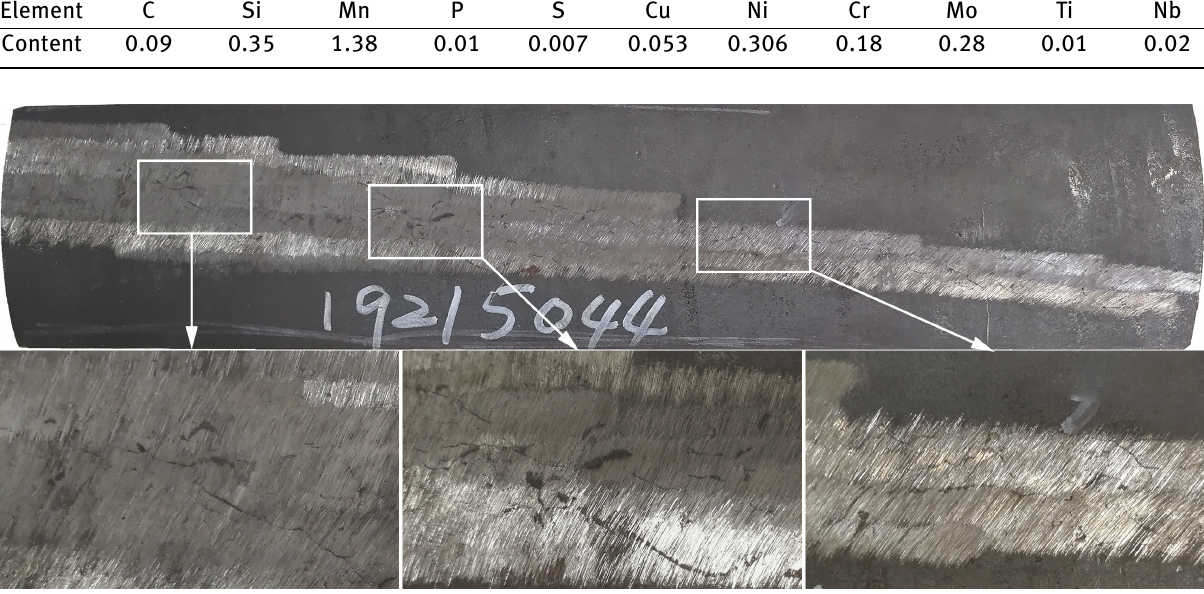
Figure 1: Typical morphology of reticular cracks on the surface of an Nb-bearing